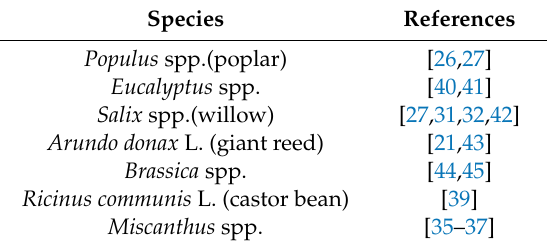
Table 1. Tree and herbaceous crops suitable for